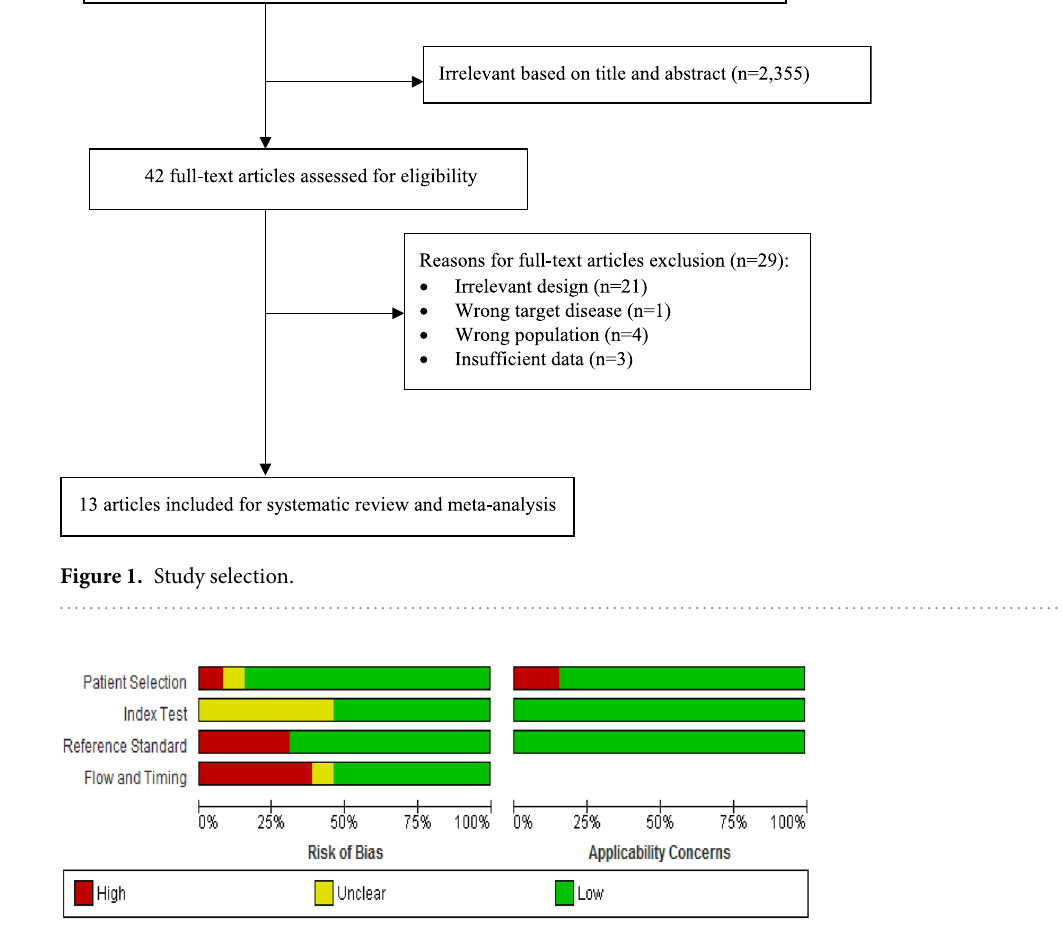
Figure 2. Graphical illustration of risk of bias and applicability